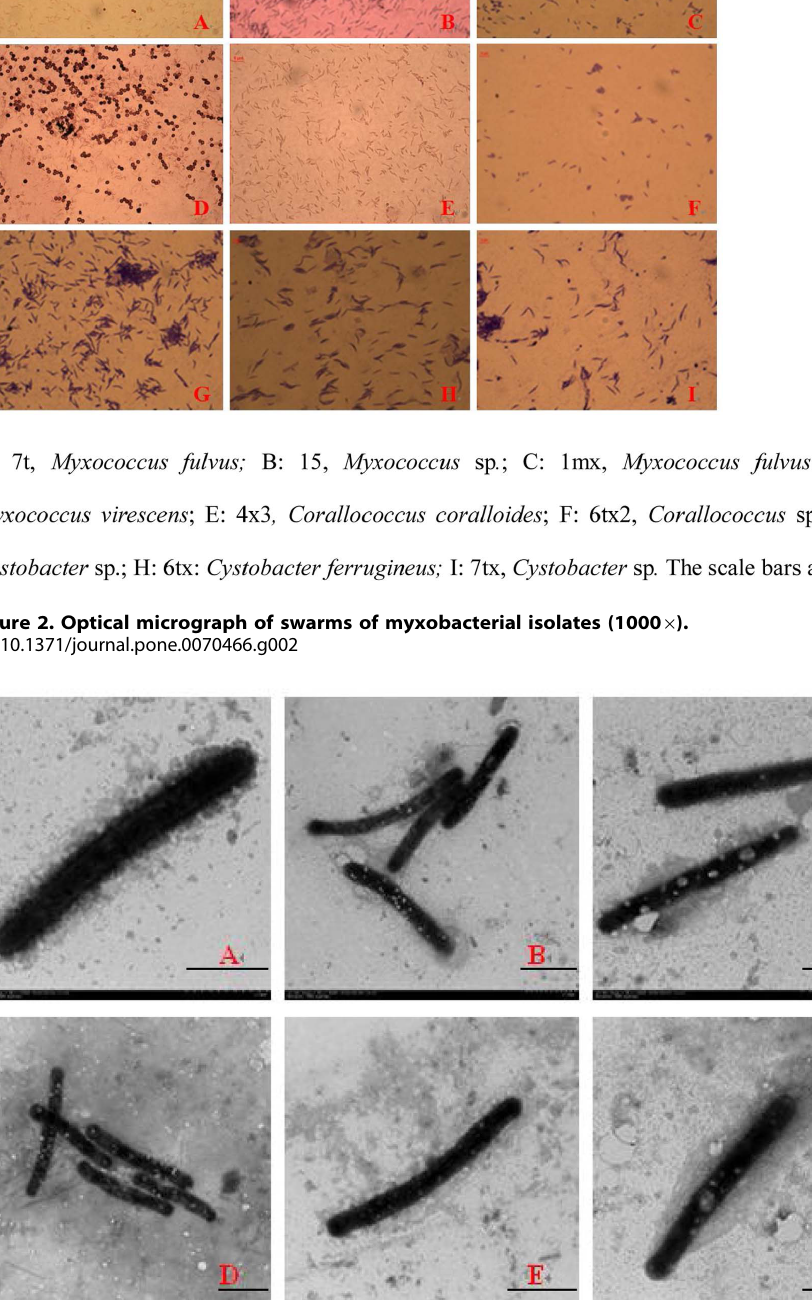
Figure 3. Electron micrograph of vegetative cells of new myxobacterial isolates (10,000 6 ). doi:10.1371/journal.pone.0070466.g003 PLOS ONE |